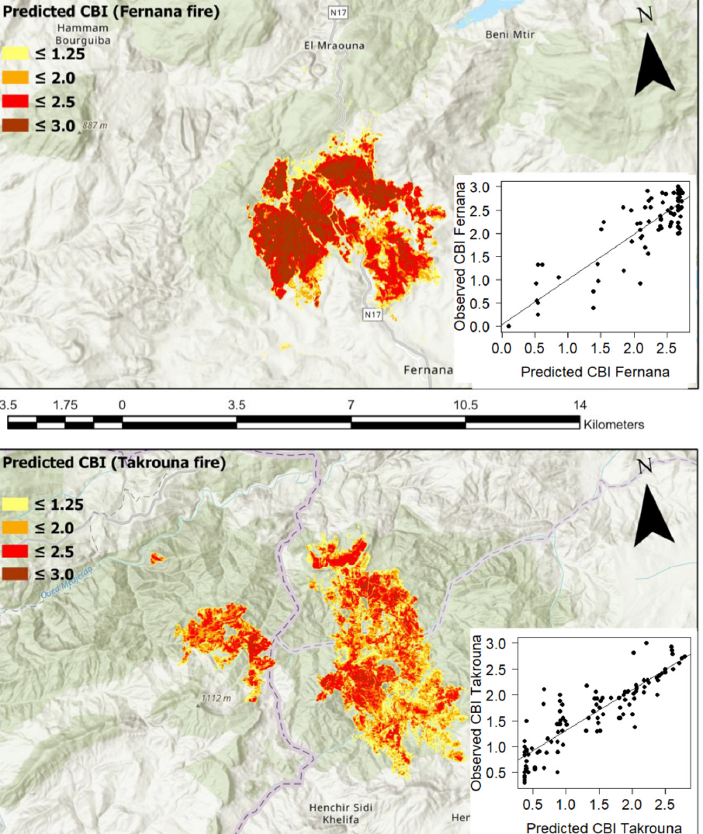
Figure 8. Maps of predicted CBI values derived from the boosted regression trees (BRT) in both fires analyzed: ( top ) F1 (Fernana fire) and ( bottom ) F2 (Takrouna fire). Inset are shown the scatterplot between the field-observed and spatialized predicted CBI values using BRT.